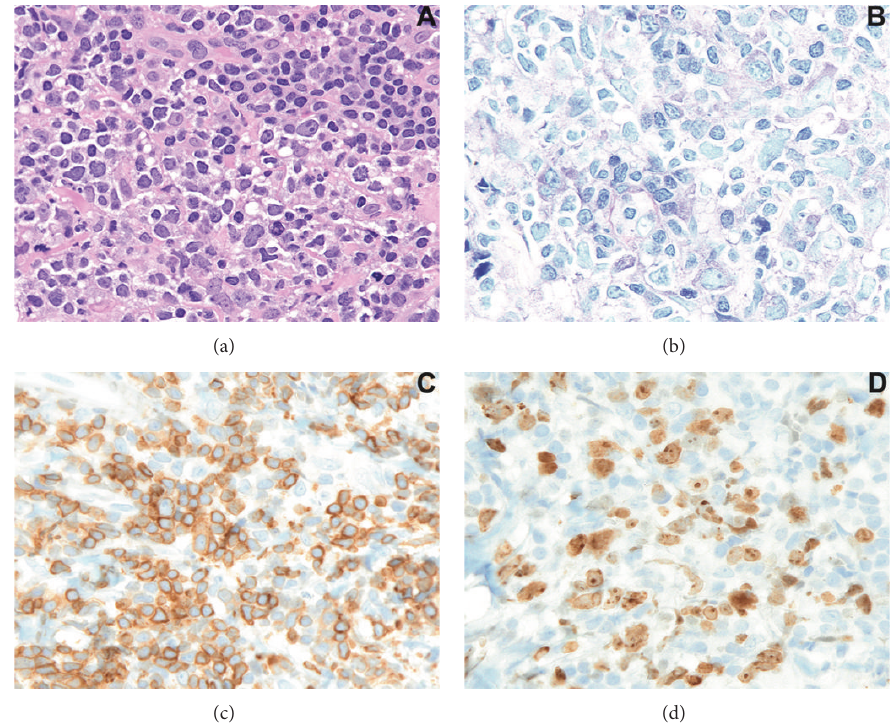
Figure 2: (a)-(b) Histopathological examination (hematoxylin-eosin and Giemsa stains); (c) immunohistochemical reactions for BCL2+; and (d) proliferation index (Ki67, MIB1). Magnification: